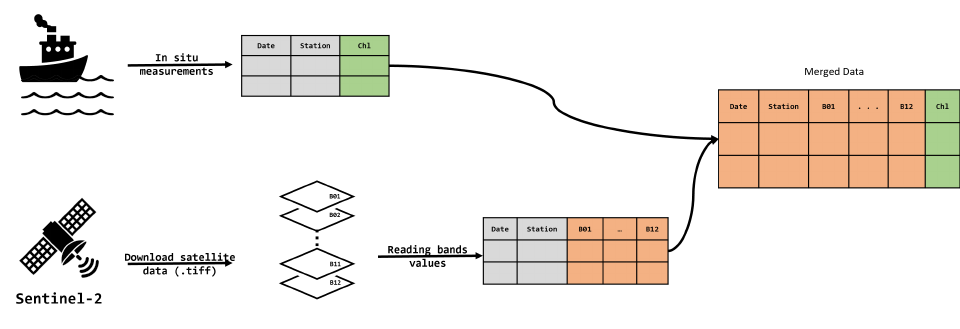
Figure 3. Data set construction.